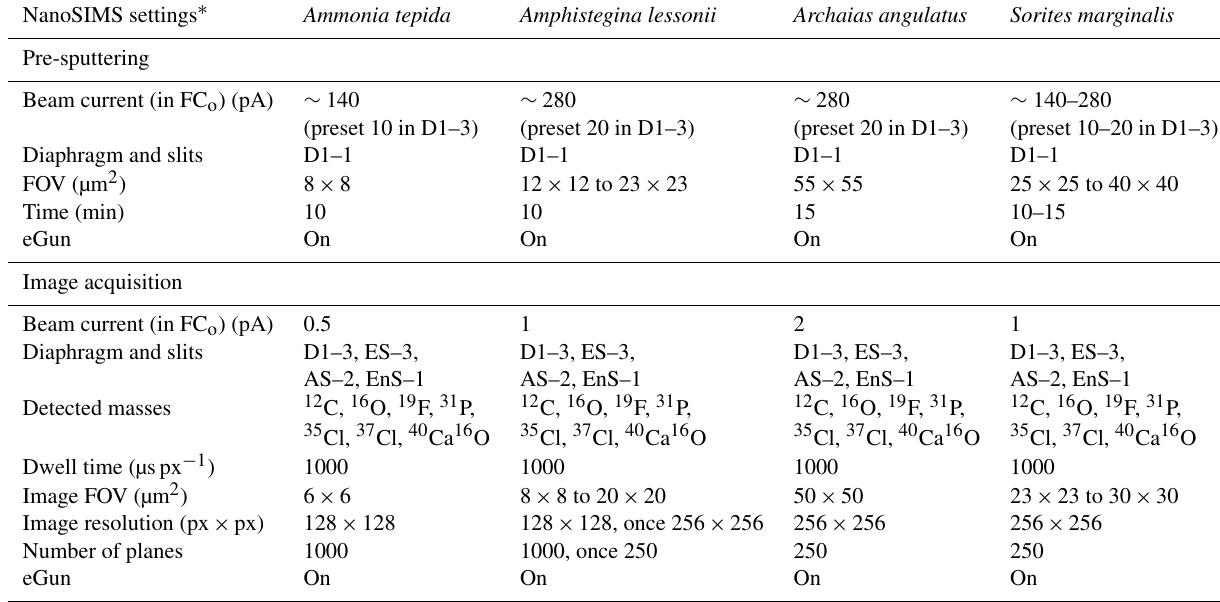
Table A2. NanoSIMS 50L acquisition